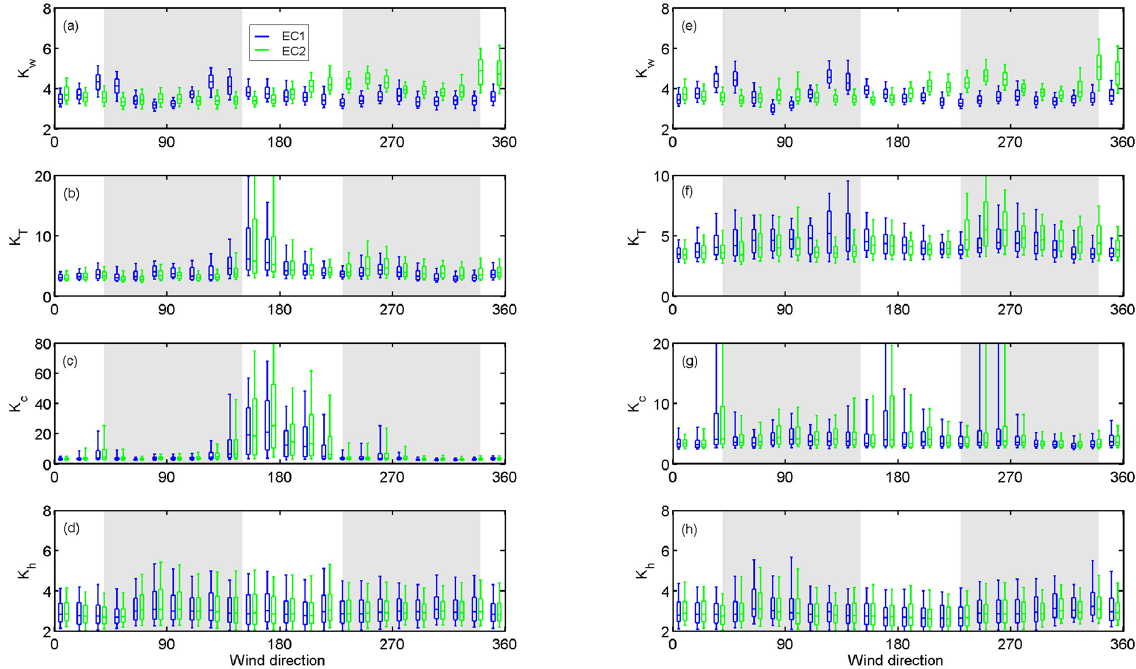
Figure A1. Kurtosis ( K ) of (a, e) vertical wind speed ( w ), (b, f) air temperature ( T ), (c, g) CO 2 ( c ) and (d, h) water vapour ( w ) as a function of wind direction for hours 06:00–21:00 (a) – (d) and 21:00–06:00 (e) – (h) for EC1 (blue) and EC2 (green) during July 2013 until September 2015. Whiskers and boxes represent the 10th, 25th, 50th, 75th and 90th